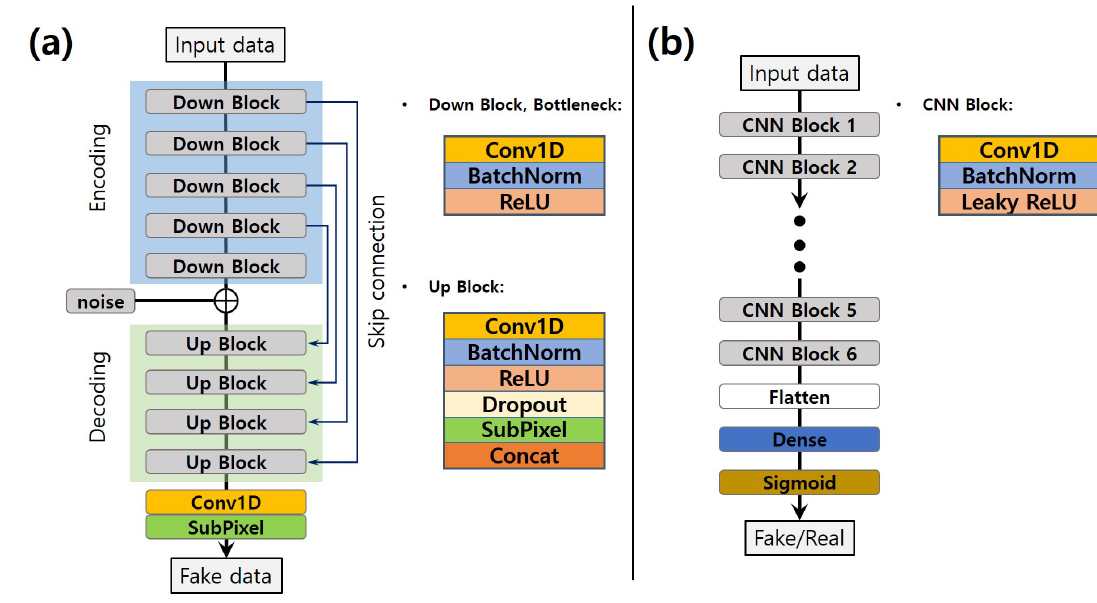
Figure 4. Architecture of ( a ) generator and ( b )